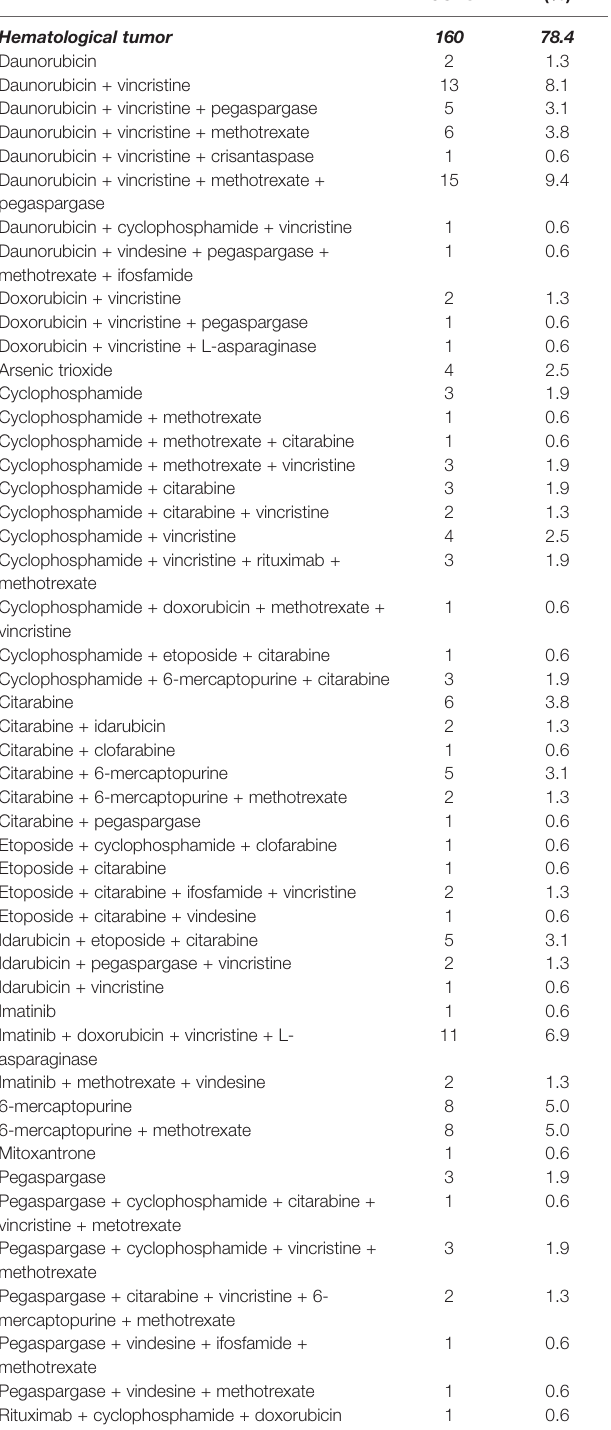
TABLE 2 | Number of non-off-label ICSRs distributed for the suspected antineoplastic protocols and the general therapeutic indication in the setting of the Campania spontaneous reporting system — January 2013 to September 2019. Cancer and suspected antineoplastic protocols Numberof